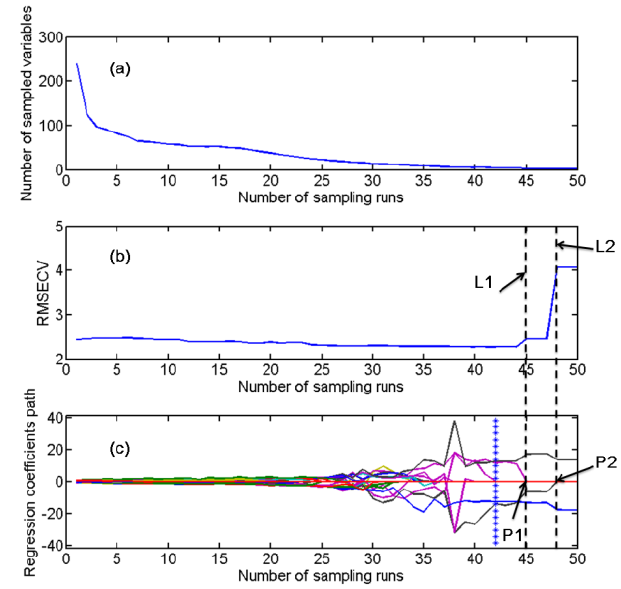
Figure 2. Changing trends of the number of sampled variables in the competitive adaptive reweighted sampling (CARS) calculation. ( a ) 5-fold the root mean square error of cross-validation (RMSECV) values; ( b ) and regression coefficients of each variable; ( c ) with the increasing of sampling runs. The line (marked by asterisk) denotes the optimal point where 5-fold RMSECV values achieve the